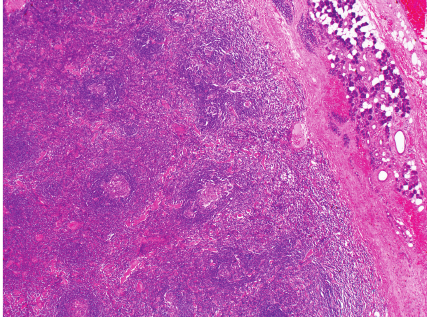
Figure 3: Low magnification of the lesion next to the parotid parenchyma (2x; H&E).